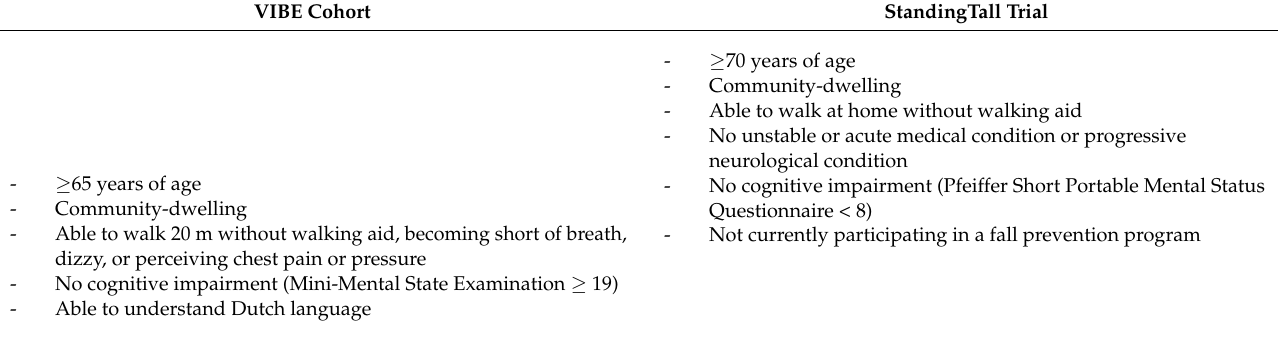
Table A1. Inclusion criteria VIBE cohort and StandingTall trial.